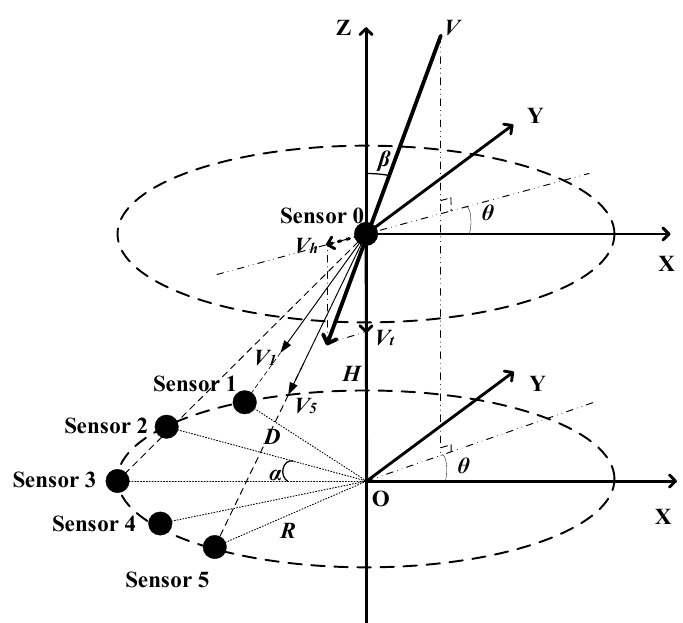
Figure 1. Structure of the ultrasonic sensor array in the 3D space.